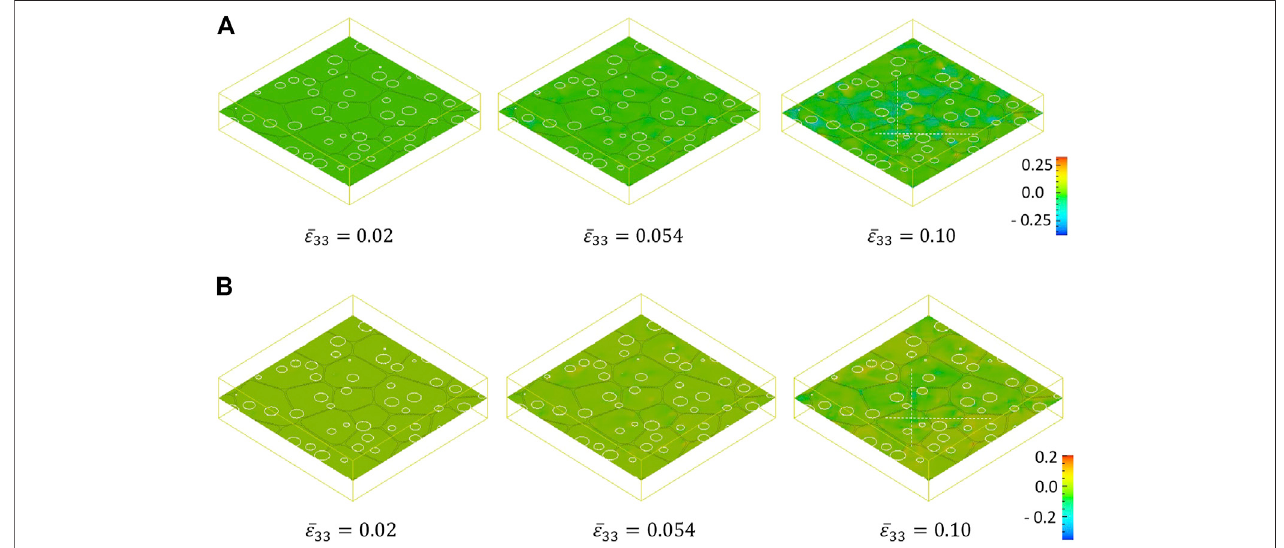
FIGURE 5 | Distributions of plastic strain ε p 13 on the plane S in polycrystalline structures with gas bubble volume fraction 9.7% at different applied strains ( ε (cid:2) 0 . 02 , 0 . 054 , and0 . 10 ) . (A) gas bubbles with initial pressure P 33